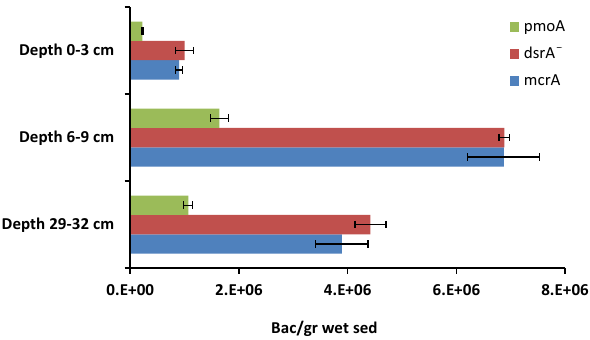
Figure 6. Profiles of functional genes from the three different depths. Green bars represent the pmoA functional gene of aerobic methanotroph, red bars represent the dsrA functional gene of sul- fate reducers and blue bars represent the mcrA functional gene from methanogens and anaerobic